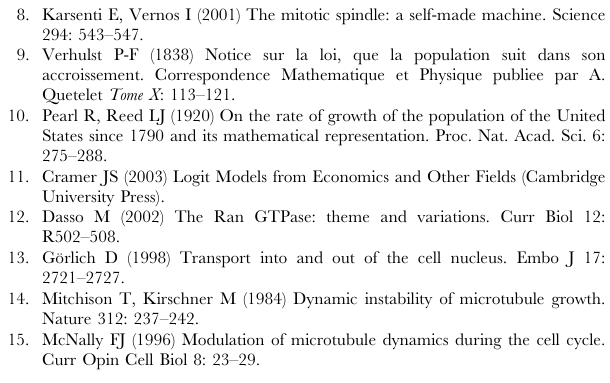
Figure S2 The model presented in this paper predicts an exponential sensitivity of MT mass to the RanGTP concentration. The plot depicts MT mass after 10 minutes as a function of in the logistic equation (see Figure 2). This exponential sensitivity has been measured by